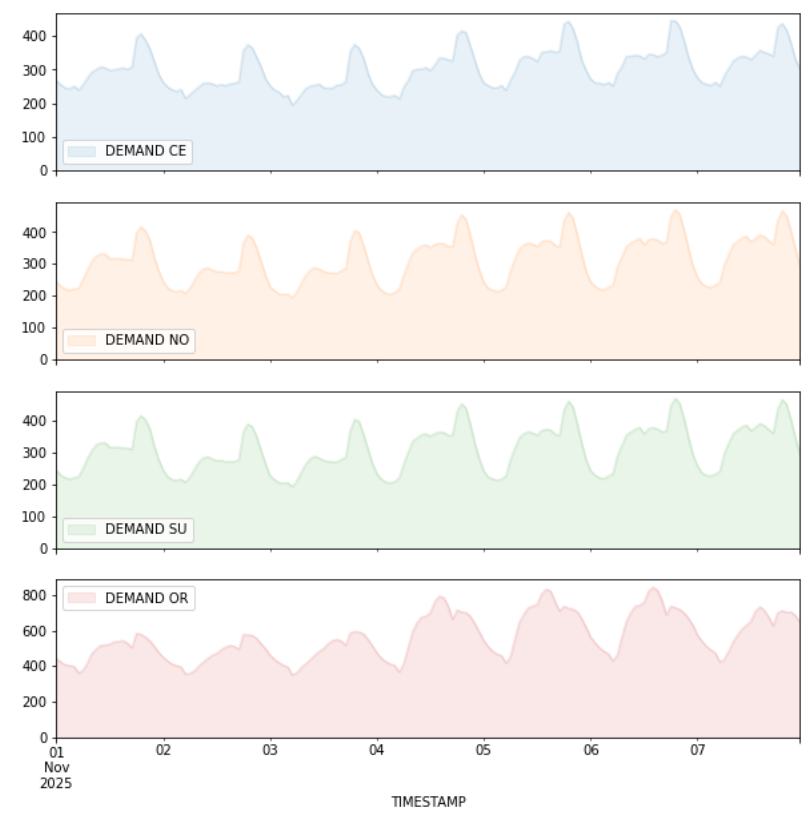
Figure 5. Load curve for all four zones (1–7 November